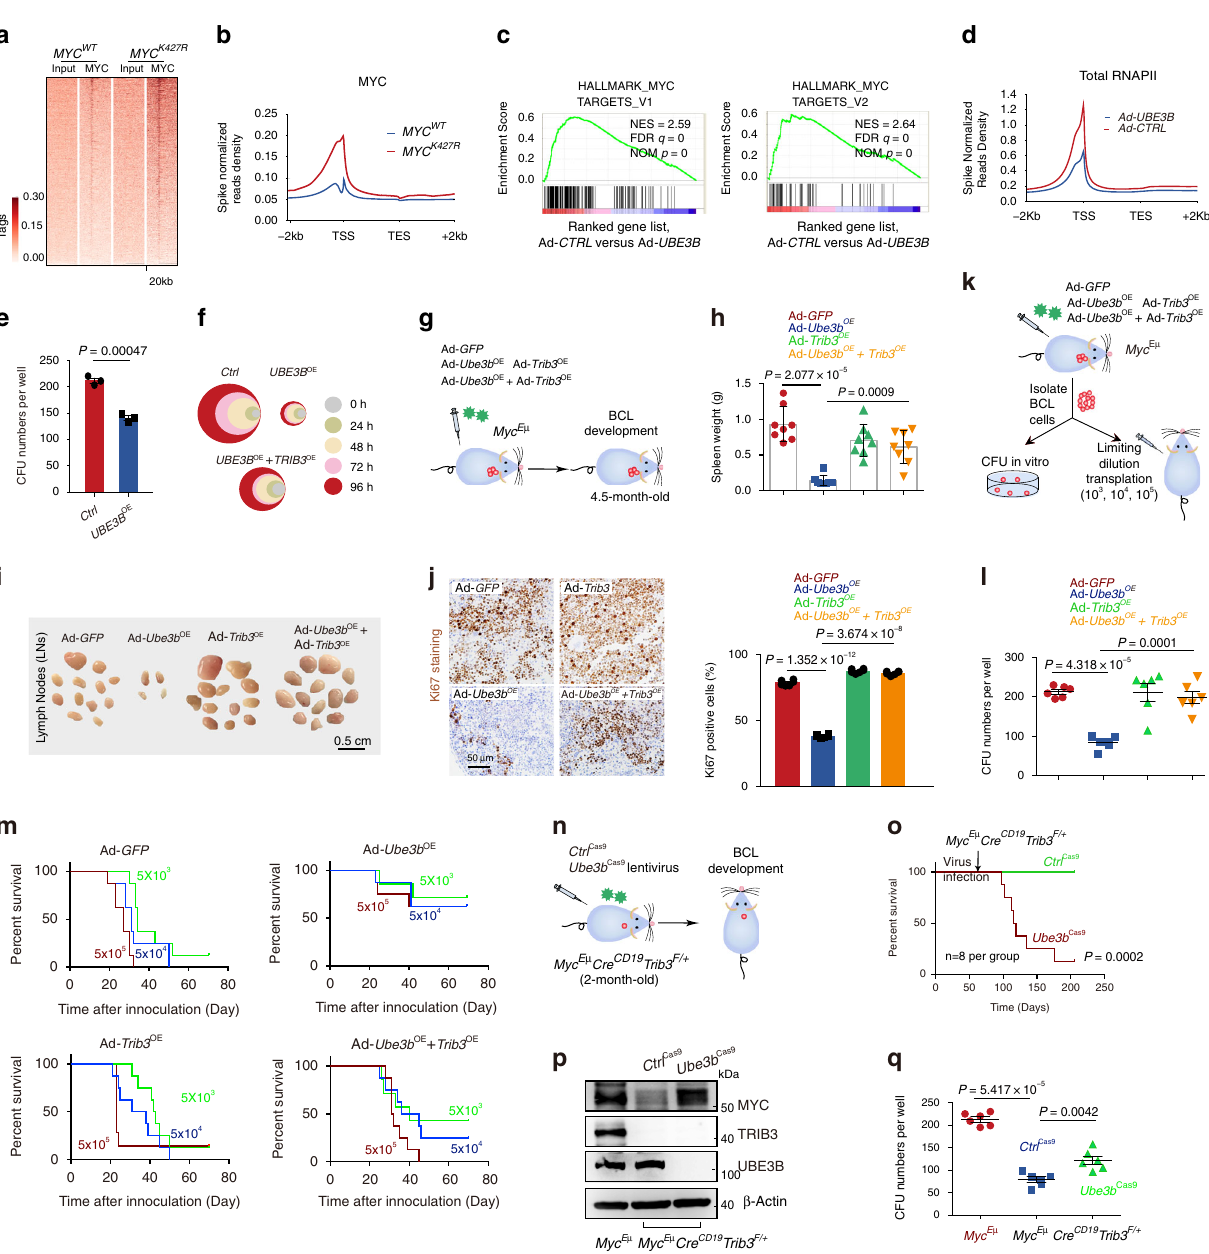
The TRIB3-MYC interaction confers a therapeutic target against lymphoma . Four α -helical peptides (CM1, CM2, CM3, and CM4) derived from C terminus of MYC were screened using the predictive I-TASSER server (Supplementary Fig. 7a), and only CM4 displayed a high binding af fi nity for TRIB3 (KD = 76.4 nM; Fig. 6a and Supplementary Fig. 7b, c). Homology modeling based on the TRIB1 crystal structure 42 predicted a hydrogen bond between Glu344 (E344) of the TRIB3 protein and the CM4 peptide (Supplementary Fig. 7d), suggesting that the C terminus of TRIB3 is the binding domain of CM4 (Fig. 6b). We further performed sequence alignment within the C termini of TRIB family members and found that E344 of TRIB3 is not conserved at the same positions on TRIB1 and TRIB2 (Supplementary Fig. 7e), indicating that CM4 may be speci fi c for TRIB3. Fur- thermore, CM4 itself, but not the scramble peptide of CM4, decreased the binding af fi nity of TRIB3 and MYC in vitro (Fig. 6c). Because the LZ and HLH domains of MYC bind